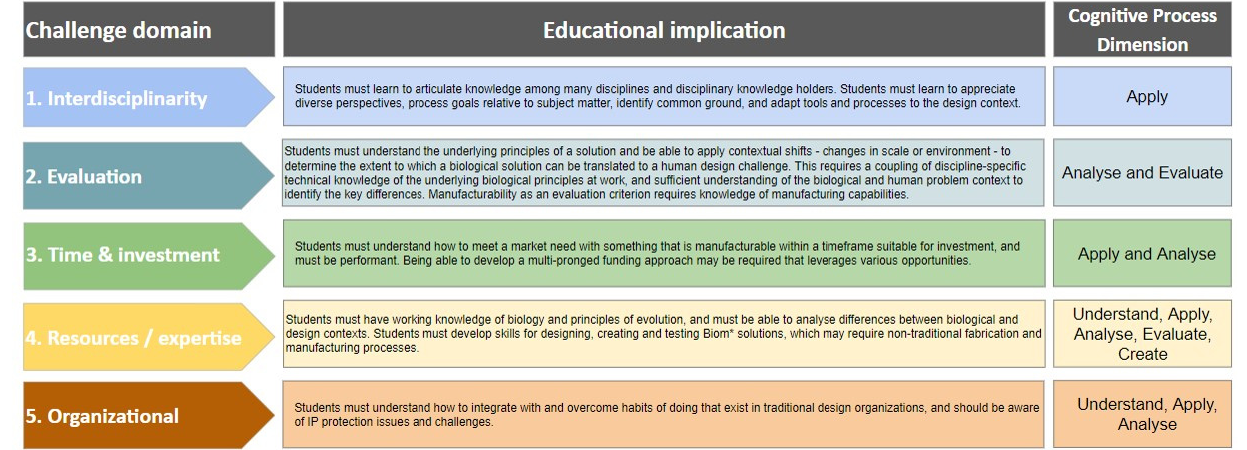
Figure 4. Educational implications that address the industry challenge domains.